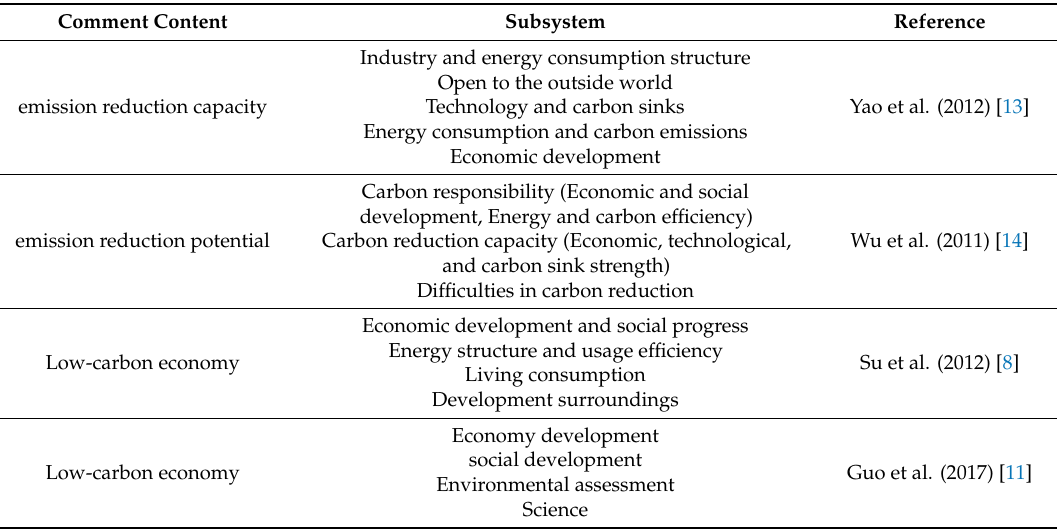
Table 1. Supporting reference of evaluation index